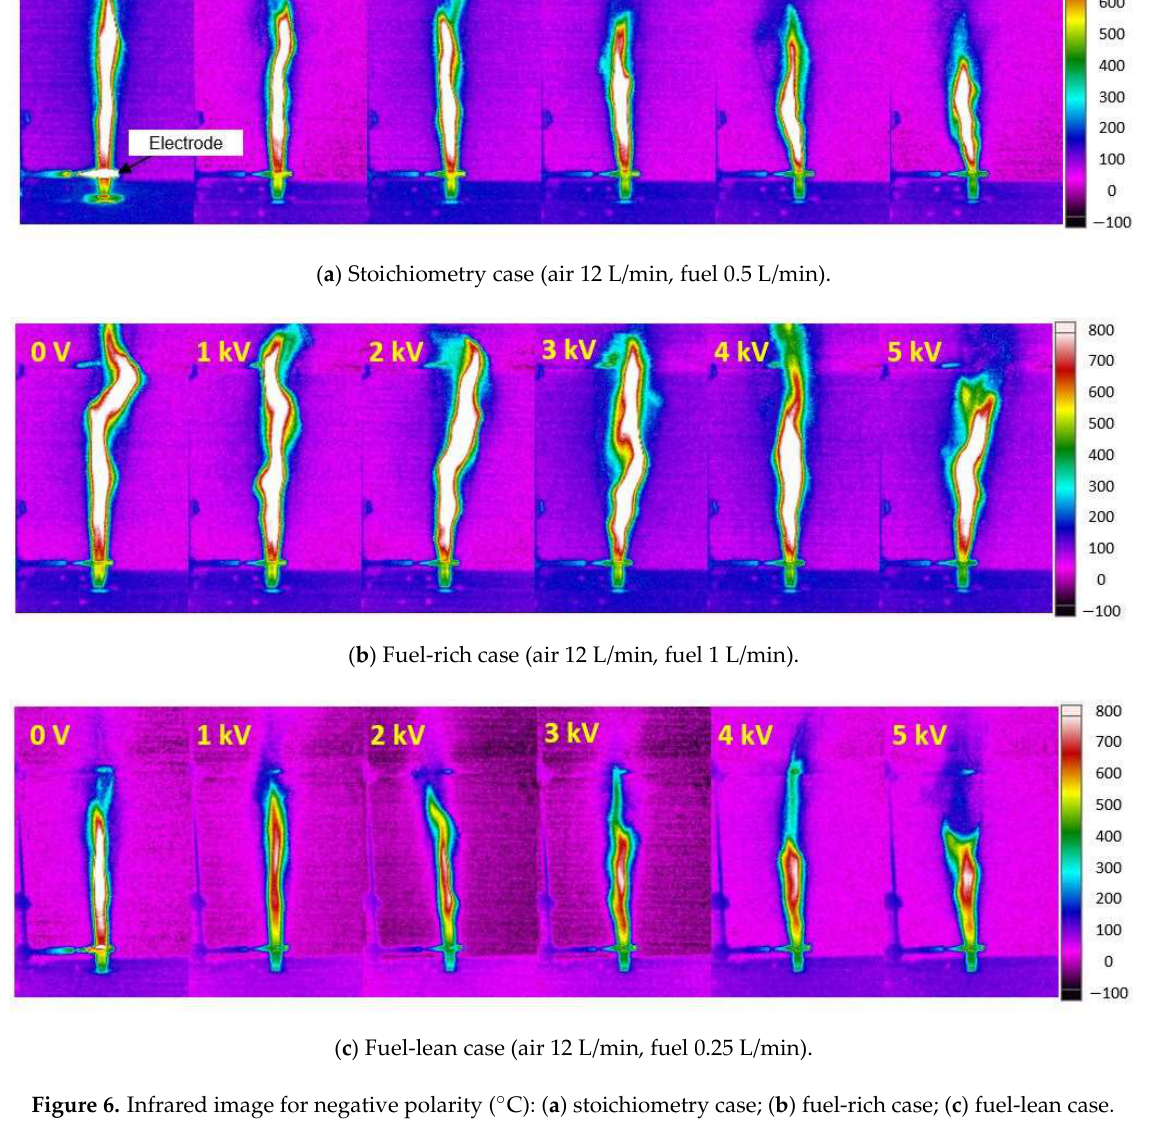
Figure 6. Infrared image for negative polarity ( ◦ C): ( a ) stoichiometry case; ( b ) fuel-rich case; ( c ) fuel-lean case. Figure 7 graphically presents the results of the flame length. As for the length of the flame presented numerically in this result, the maximum length from the burner surface to the part of the flame at 600 ◦ C or higher was defined as the length of the flame. The length of 20 thermal images of the flame was measured, and the average was presented as a result.